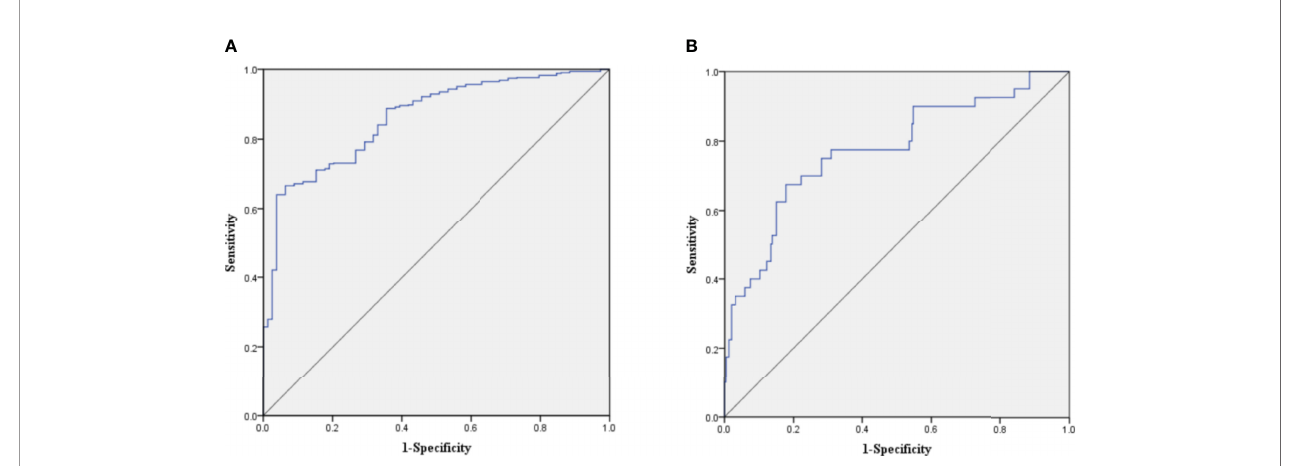
FIGURE 2 | (A) Receiver operating characteristic (ROC) curve of the prediction model in the development cohort. (B) ROC curve of the prediction model in the validation